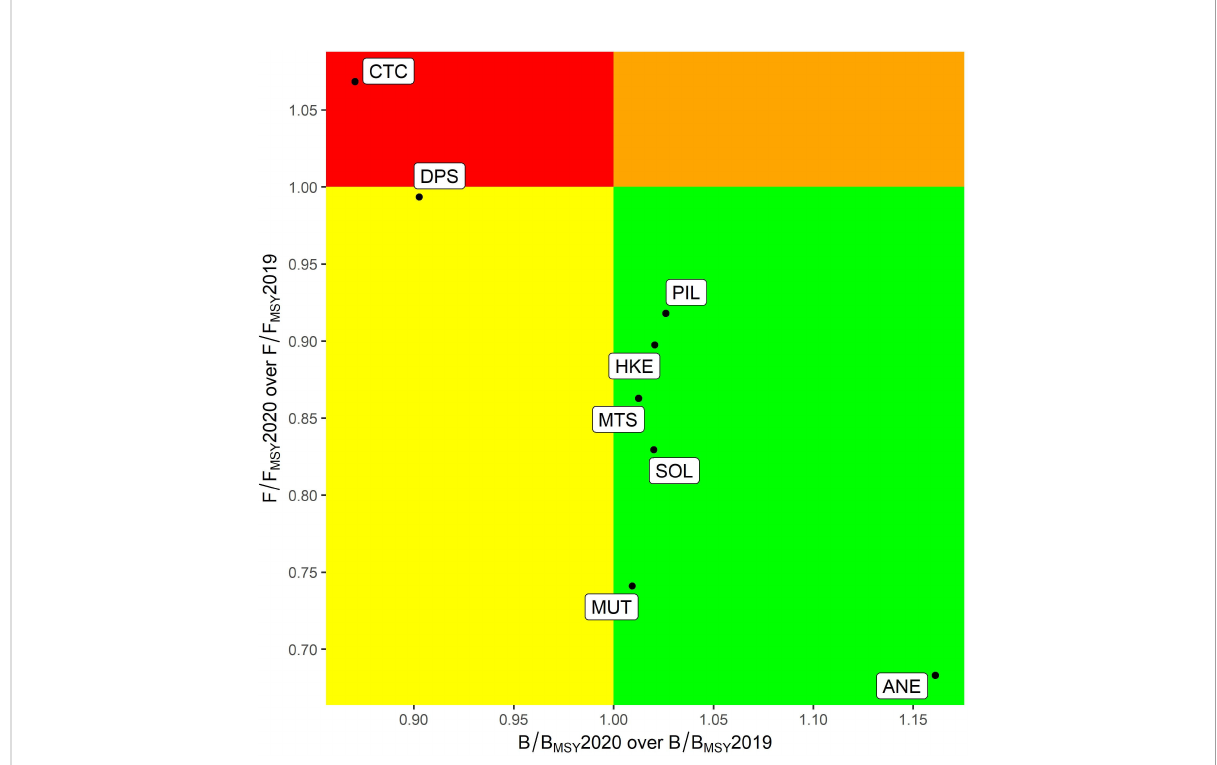
FIGURE 4 Comparative Kobe plot showing the 2020/2019 ratio of the F/F MSY and B/B MSY outputs from the CMSY/BSM outputs of eight Adriatic Sea Target